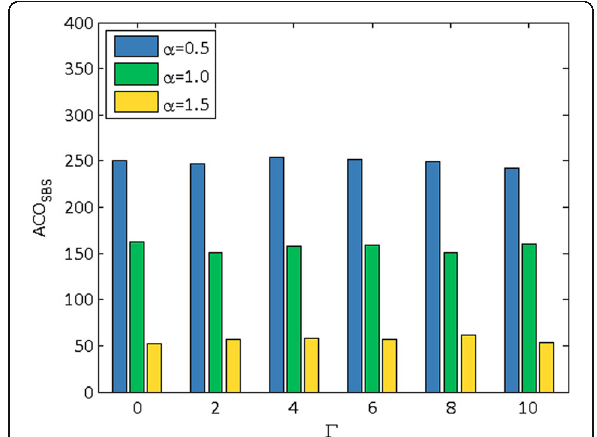
Fig. 20 Impact of Zipf parameter to hit rate in the SBS level in ER model ( d UE ¼ 4 ; N UE ¼ 60 ; Γ ¼ 8 ; T SBS